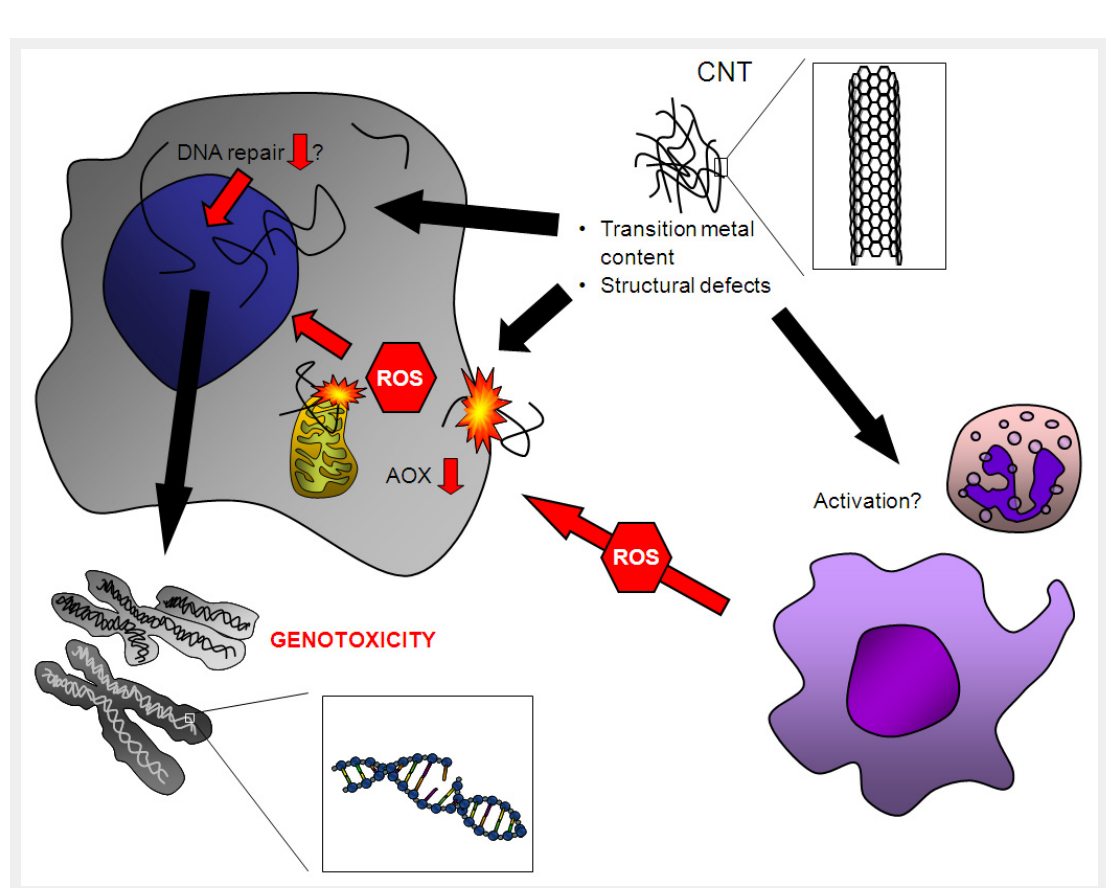
Proposed mechanisms of CNT genotoxicity. The presence of structural defects and transition metals has been implicated in their genotoxic potential. CNTs can induce ROS formation by interaction with cellular components, such as mitochondria and the cell membrane, and are capable of compromising intracellular antioxidant (AOX) defences. Contamination with transition metals may also contribute to oxidative DNA damage induction. In addition, CNT have been reported to disturb the mitotic apparatus, which could explain aneugenic effects as observed in several studies. Whether CNT are capable of inhibiting DNA repair is currently unknown. Secondary genotoxic effects may result from ROS that are generated from recruited phagocytes during CNT-induced inflammation and/or activation of these cells. Further research is needed to unravel the relevance of each of the above postulated mechanisms that should take into account realistic exposure